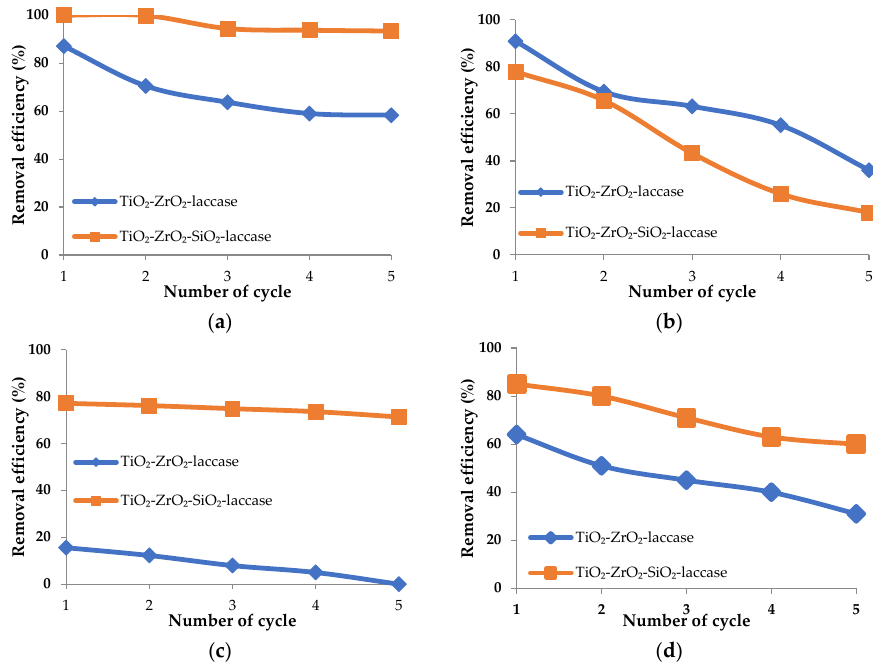
Figure 7. Removal efficiencies of: ( a ) ARS; ( b ) RRBR; ( c ) RB5; ( d ) mixture of dyes. Concentration of 5 mg/L, temperature of 25 °C duration of 1 cycle—24 h. The errors of all measurements do not exceed 5%.